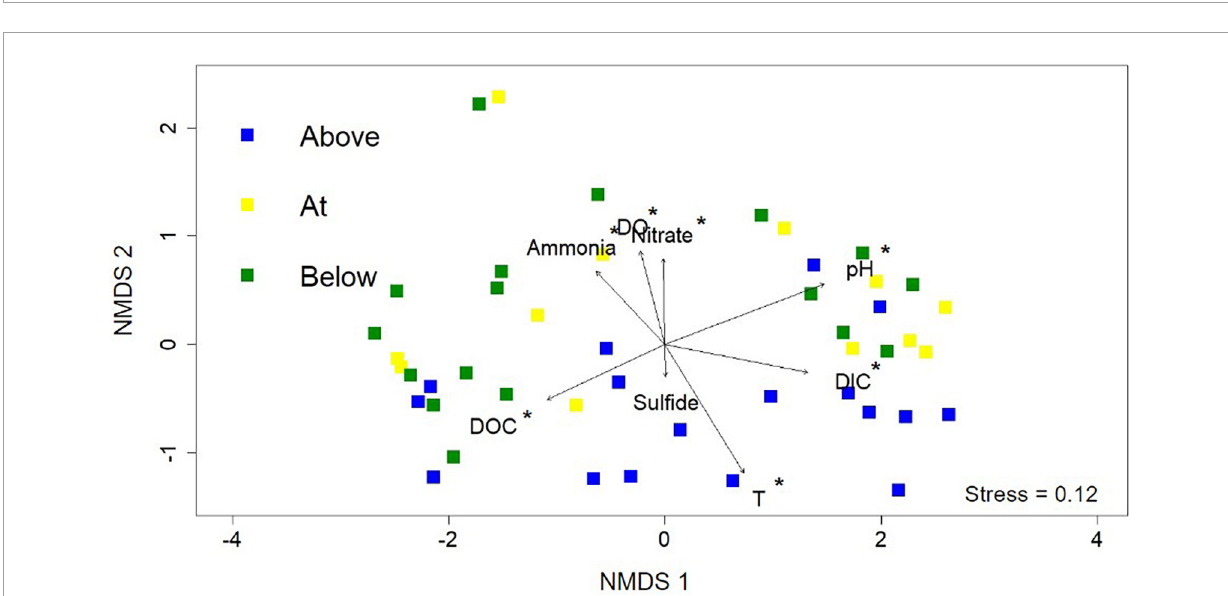
FIGURE4 Non-metric multidimensional scaling (NMDS) analysis using the 16S rRNA gene sequencing data from each of the 46 samples. Each point represents the normalized microbial community composition determined in a hot spring sample while the distance between points represents the dissimilarity. Sample point colors (blue, yellow, and green) refer to the position along the photosynthetic fringe (above, at, below, respectively). Geochemical data are added as vectors; vectors that correlate with an ordination axis with a p -value < 0.05 are indicated by an